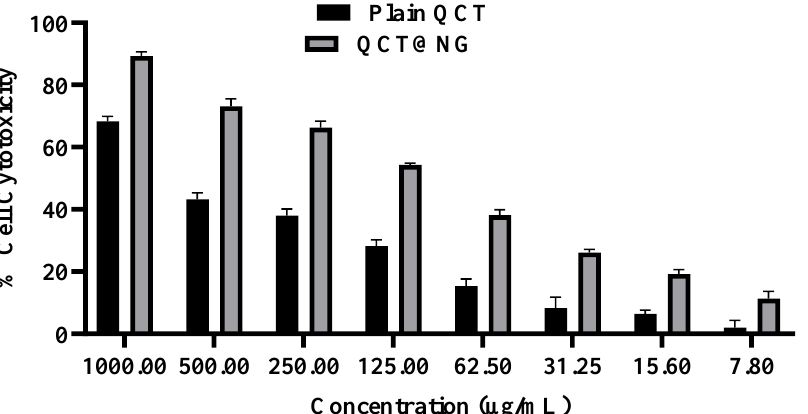
Figure 9. Percent cell cytotoxicity of plain QCT and QCT@NG on A431 human skin cancer cell